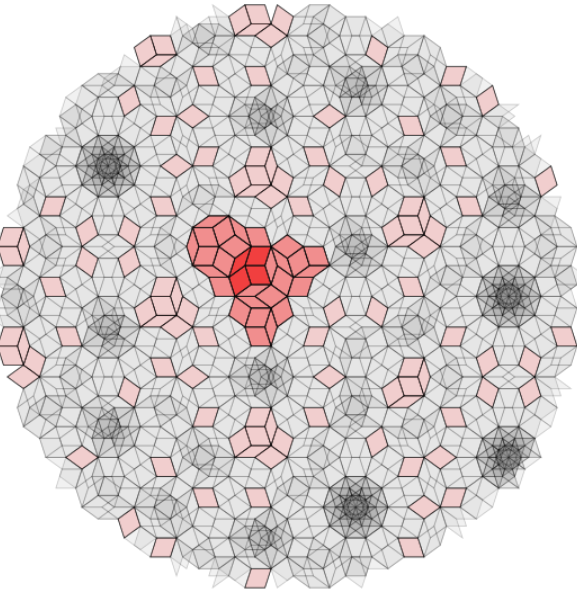
Figure 2. Empire of a K vertex patch (red), its local empire (dark pink) and its non-local empire field (light